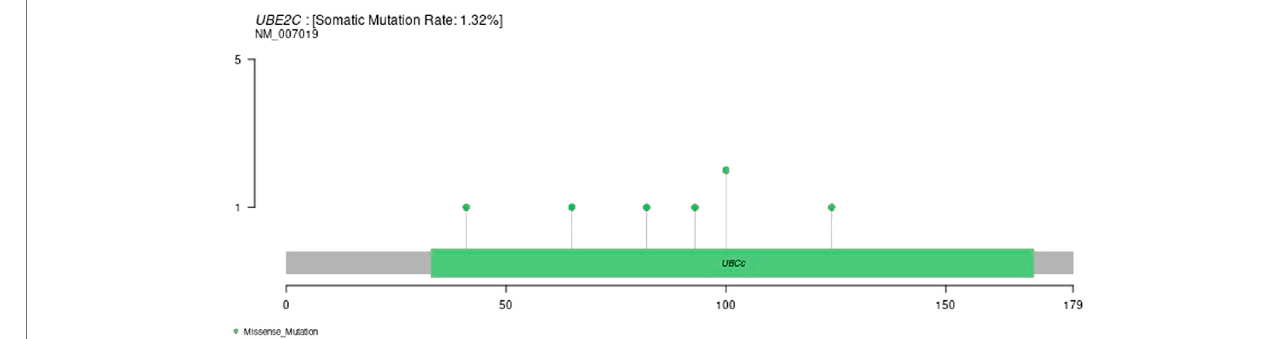
FIGURE 12 | Gene variation data in 33 tumors.